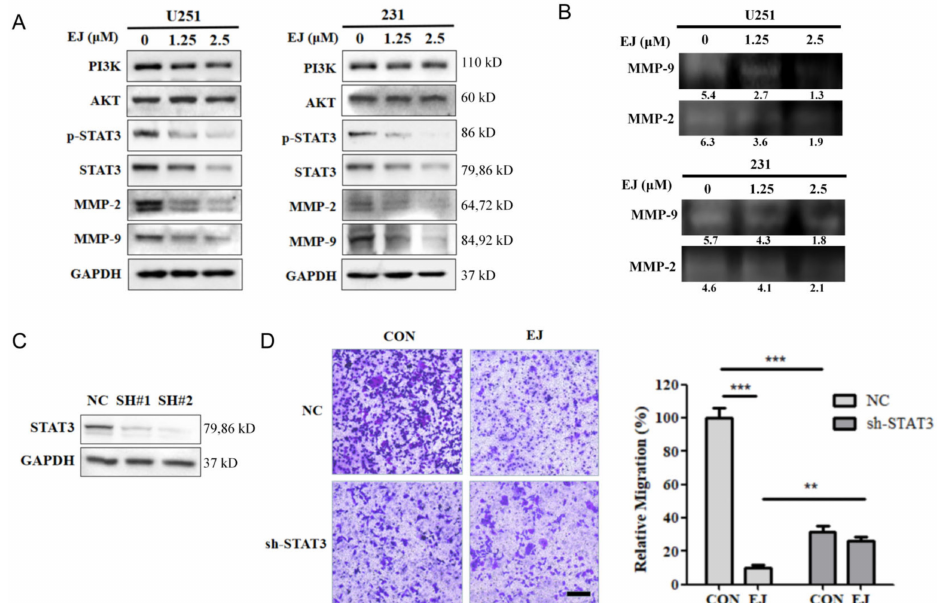
Figure 4. EJ suppressed cancer cell metastasis through the STAT3 signaling pathway. ( A ) Effect of EJ on the expression level of STAT3 and AKT signaling pathway-related proteins were detected by Western blot. ( B ) EJs inhibitory effect on the activity of MMP-2 and MMP-9 was detected by gelatinase profiling assay (the gray-scale quantification values are reported below the strips). ( C ) Knockdown of STAT3 in U251 cells by shRNA transfection. U251 cells were transfected with STAT3-shRNA (SH#1 and SH#2) plasmids or negative control shRNA plasmids (NC). The expression of STAT3 in U251 cells was determined using Western blotting. ( D ) Knockdown of STAT3 significantly inhibited the migration of U251 cells and reversed the ability of EJ to inhibit metastasis in different groups of cells using transwell assays (** p < 0.01, *** p <